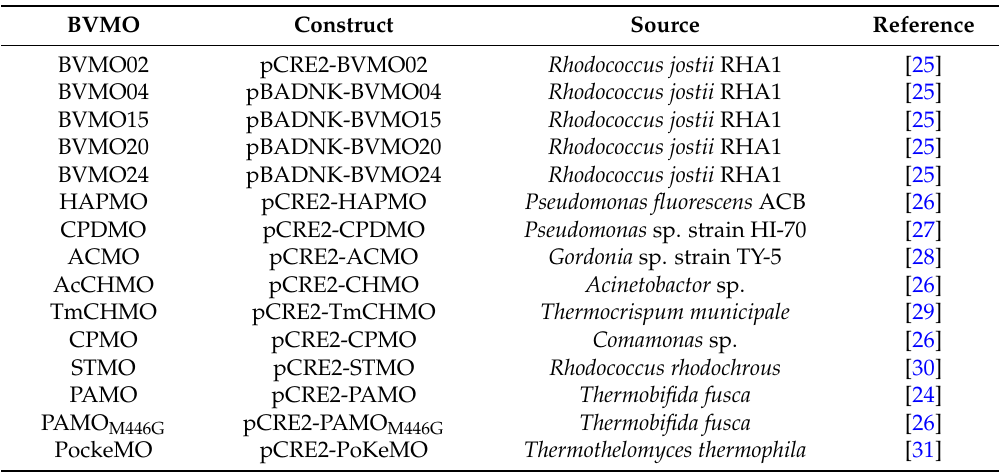
Table 3. PTDH-BVMOs constructs used along with their source